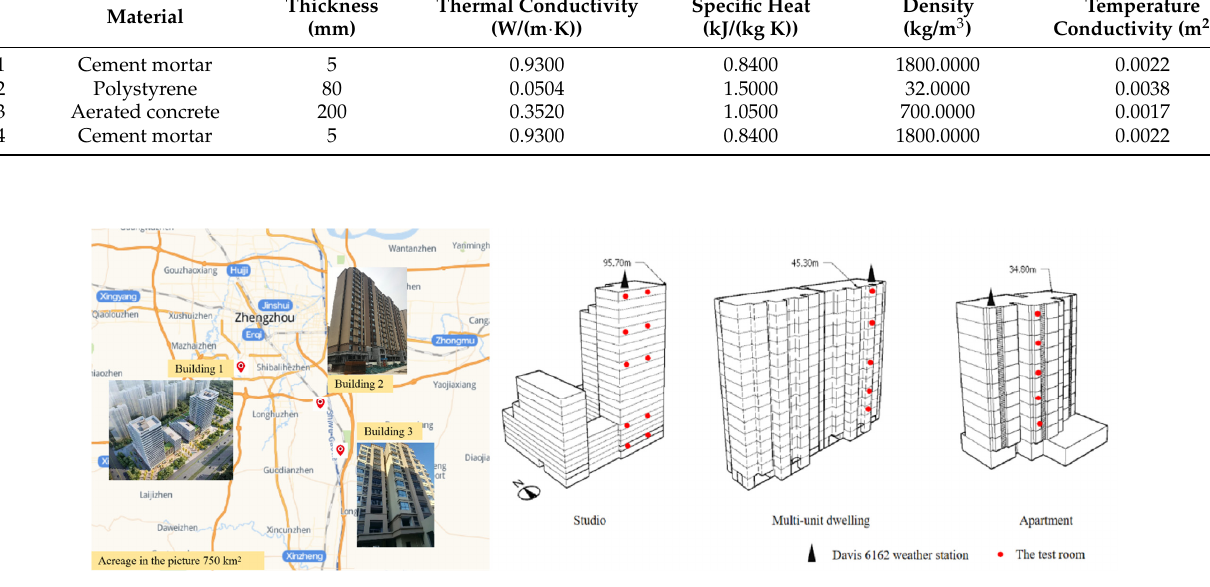
Table 2. Thermophysical parameters of the external wall of measured buildings.